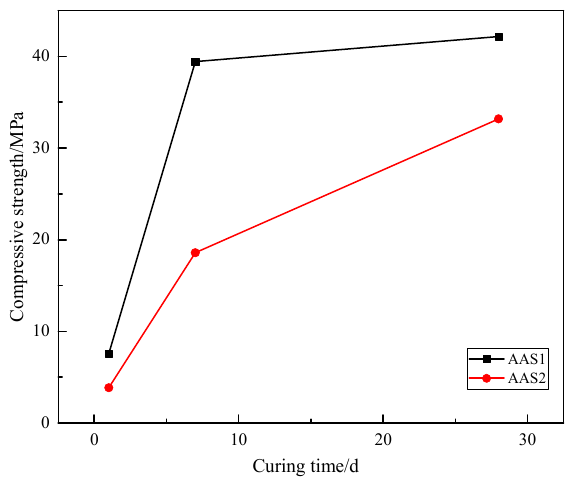
Figure 8. Compressive strength of alkali-activated slags.